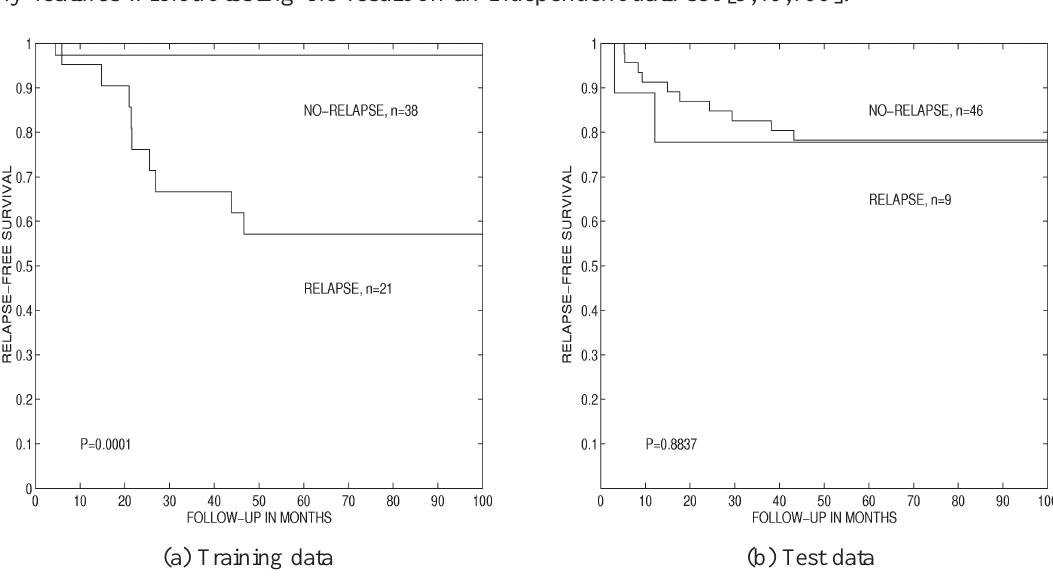
Fig. 3. Kaplan–Meier estimated survival curve of patients classified as “relapse probable” and “relapse unlikely” using a threshold on the canonical variable of the two best features from the discriminant analysis. The resubstitution classification result is presented for the training data. The canonical variable results in two significantly different survival curves in the training data, while there is almost no visual difference between the two survival curves in the test